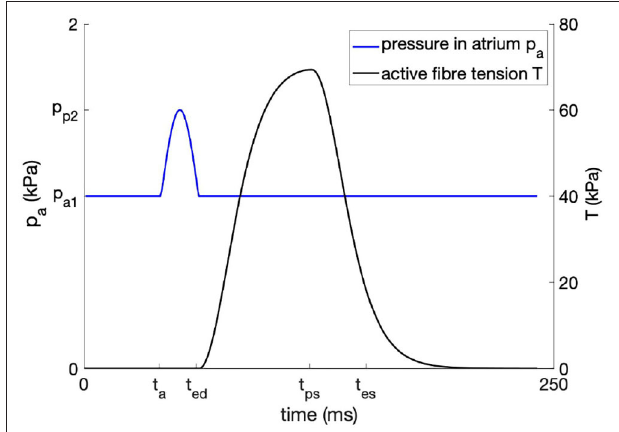
FIGURE 1 | Temporal evolution of the time-dependent atrial pressure and the active fiber tension.